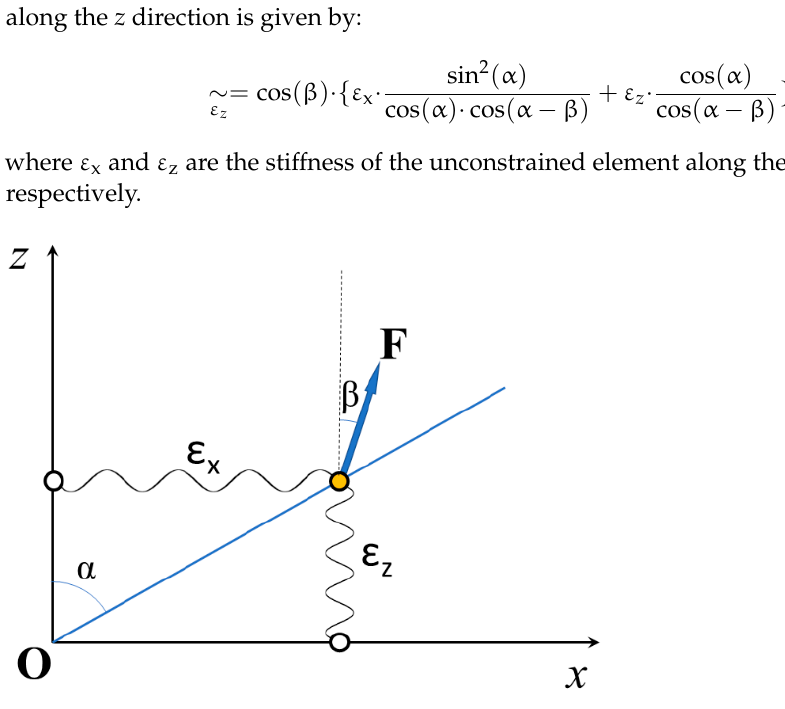
Figure 1. Schematic 2D representation of an elastic element with different stiffness values ε x and ε z along the x and z directions, respectively. The blue line at angle α with the z axis represents the structural constraint for the movement of the tip of the element (orange circle) when force F (blue arrow) is applied.